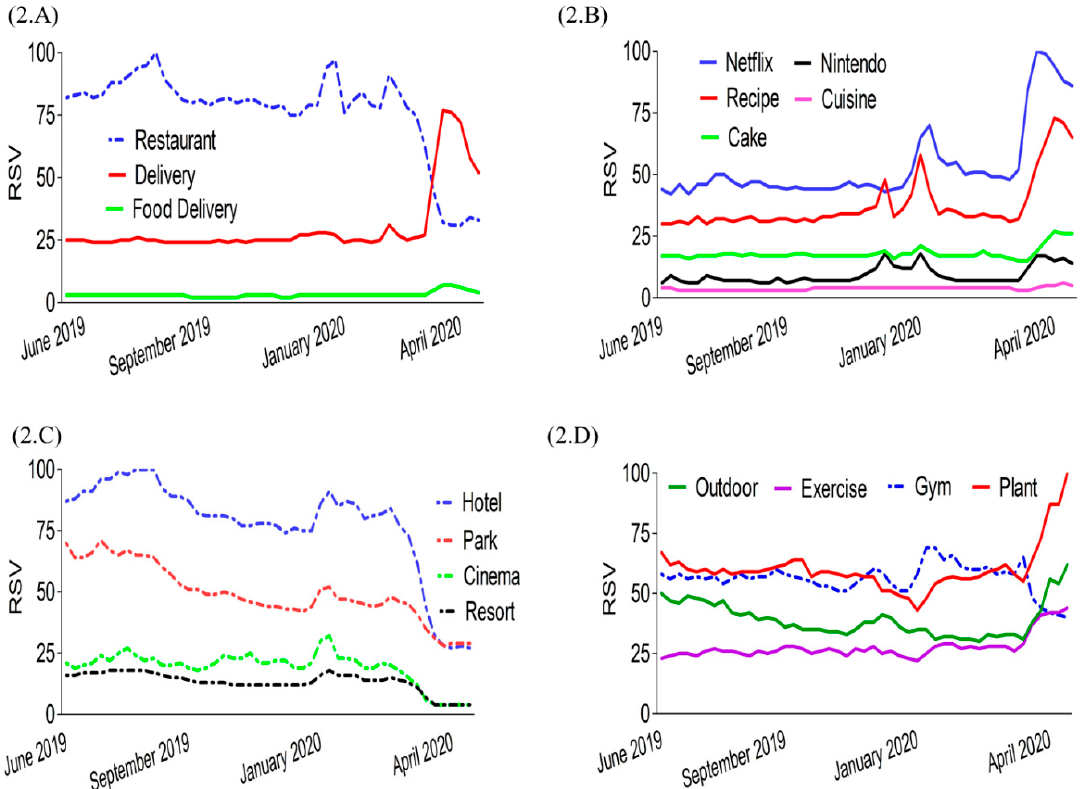
Figure 2. Global trend curves for dietary and lifestyle behavior-related search terms from 1 June 2019 to 27 April 2020. ( A ) Dietary behavior, ( B ) Lifestyle: indoor behavior, ( C , D ) Lifestyle: outdoor behavior. RSV: relative search volumes.